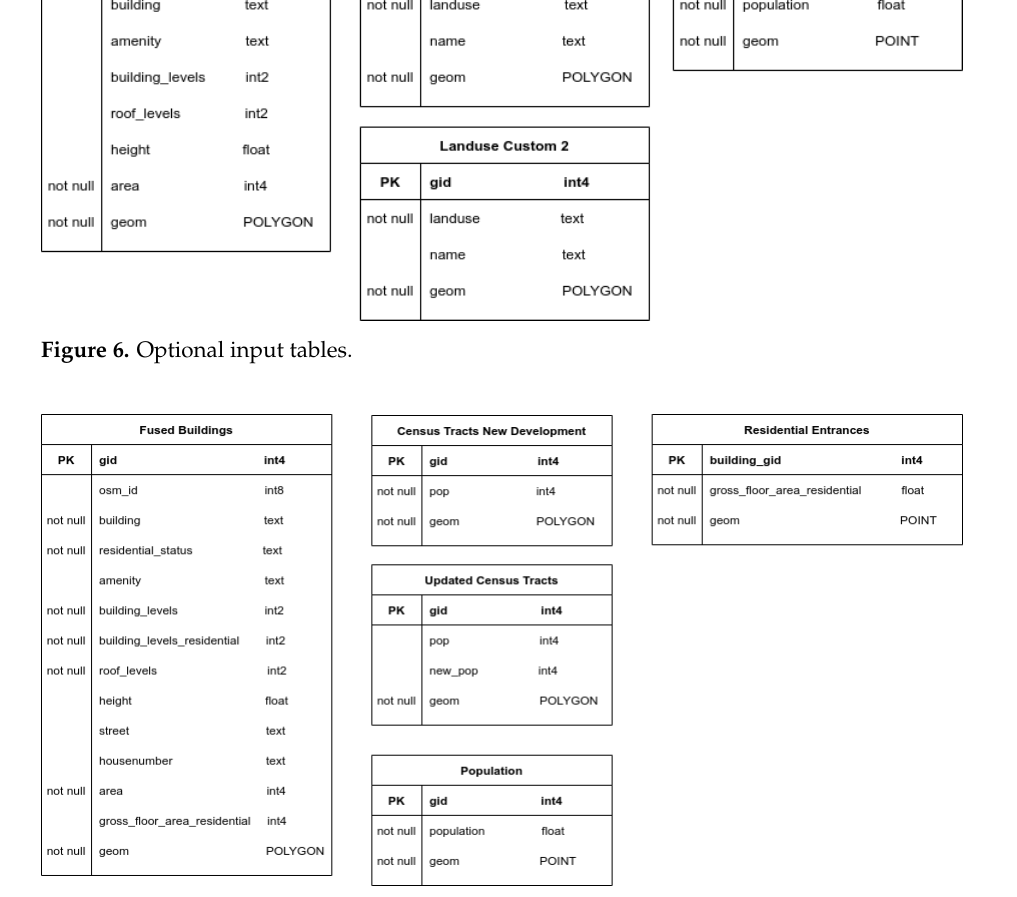
Figure 7. Data structure output